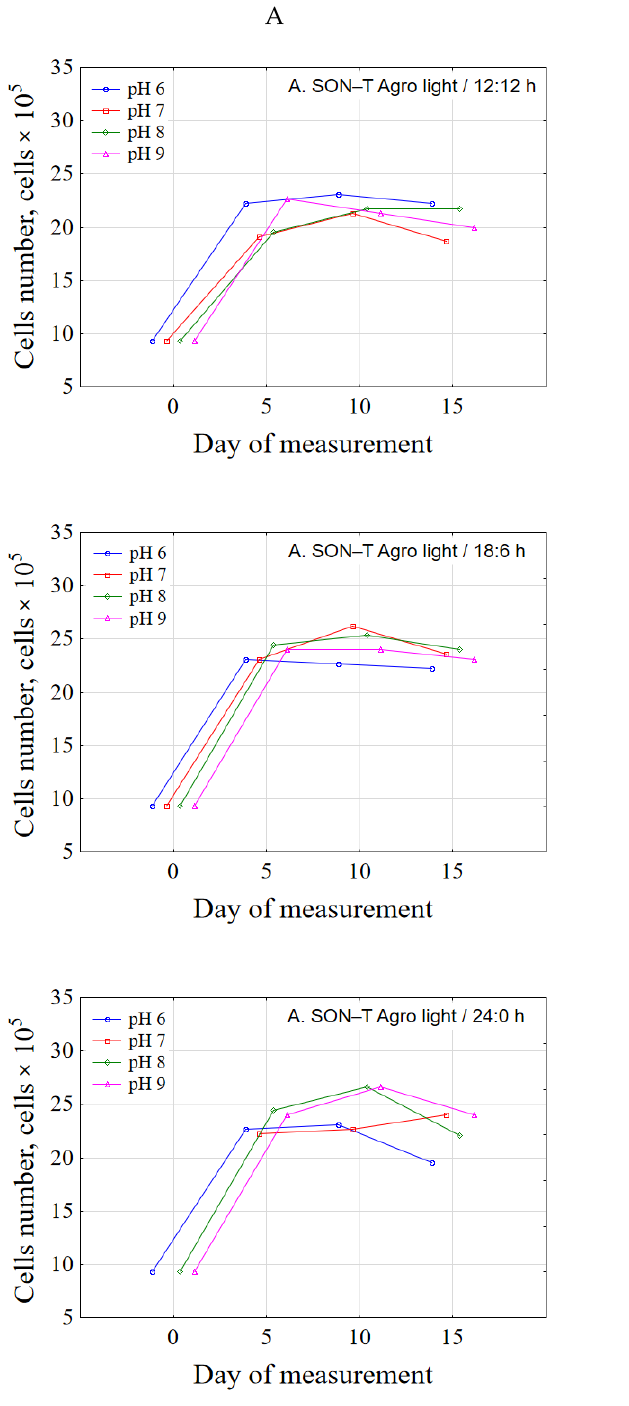
Figure 8. Dynamics of algae cell changes in culture in SON-T Agro light ( A ) and LED light ( B ) during different light:dark cycle. The mean values of the number of microalgae cells indicate that the time of lighting culture, and the pH had no significant effect on the obtained values (Figure 9). Under SON-T Agro lighting, the highest values were recorded at the 18/6 h photoperiod (19.3 × 10 5 –20.8 × 10 5 ), and under LED lighting, the highest average number of microalgae cells was recorded at 12/12 h (18.9 × 10 5 –20.8 × 10 5 ), however, as shown in Figure 5, they did